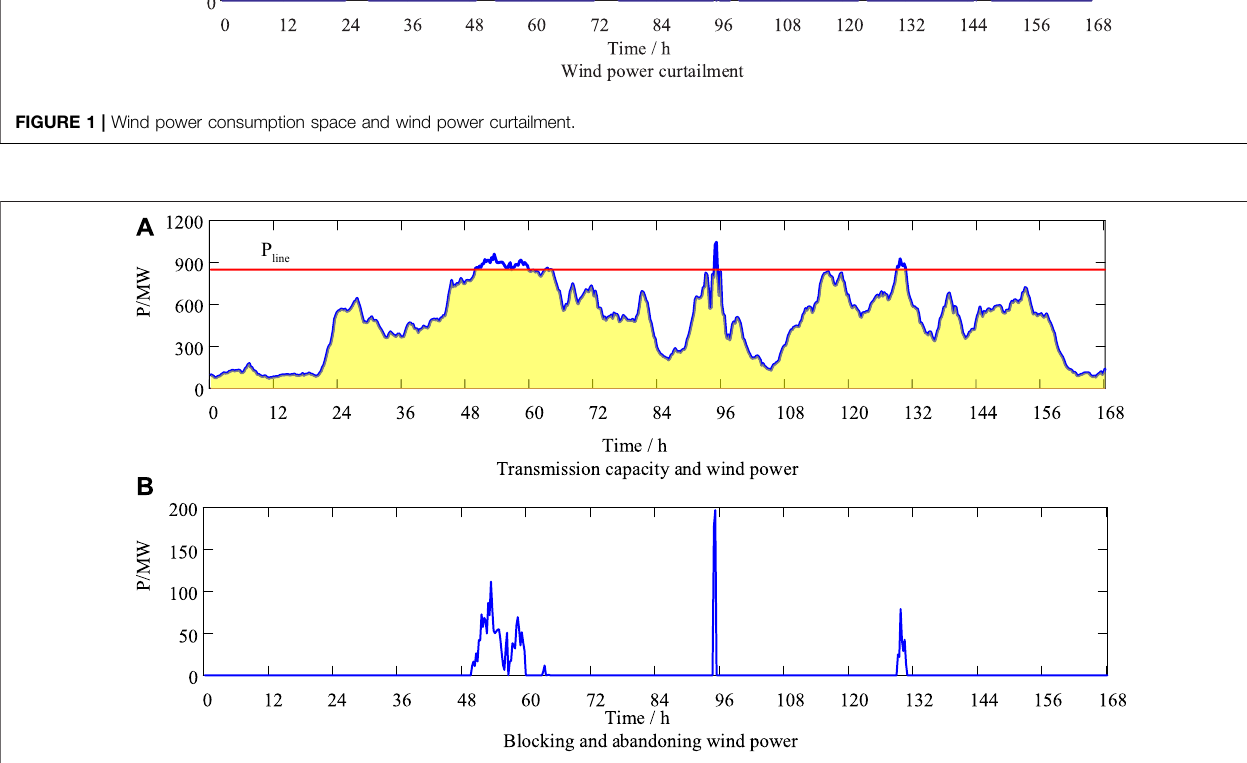
FIGURE 2 | Transmission capacity and blocked wind power